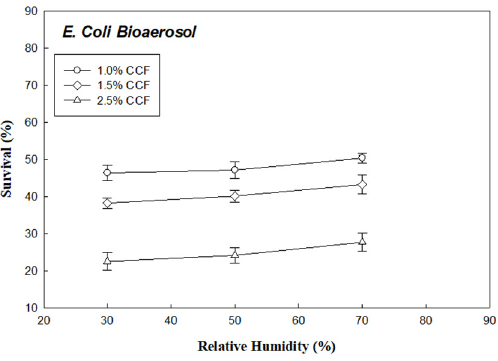
Figure 5. Survival of E. coli bioaerosols through the chitosan-coated and untreated filters in different relative humidity.